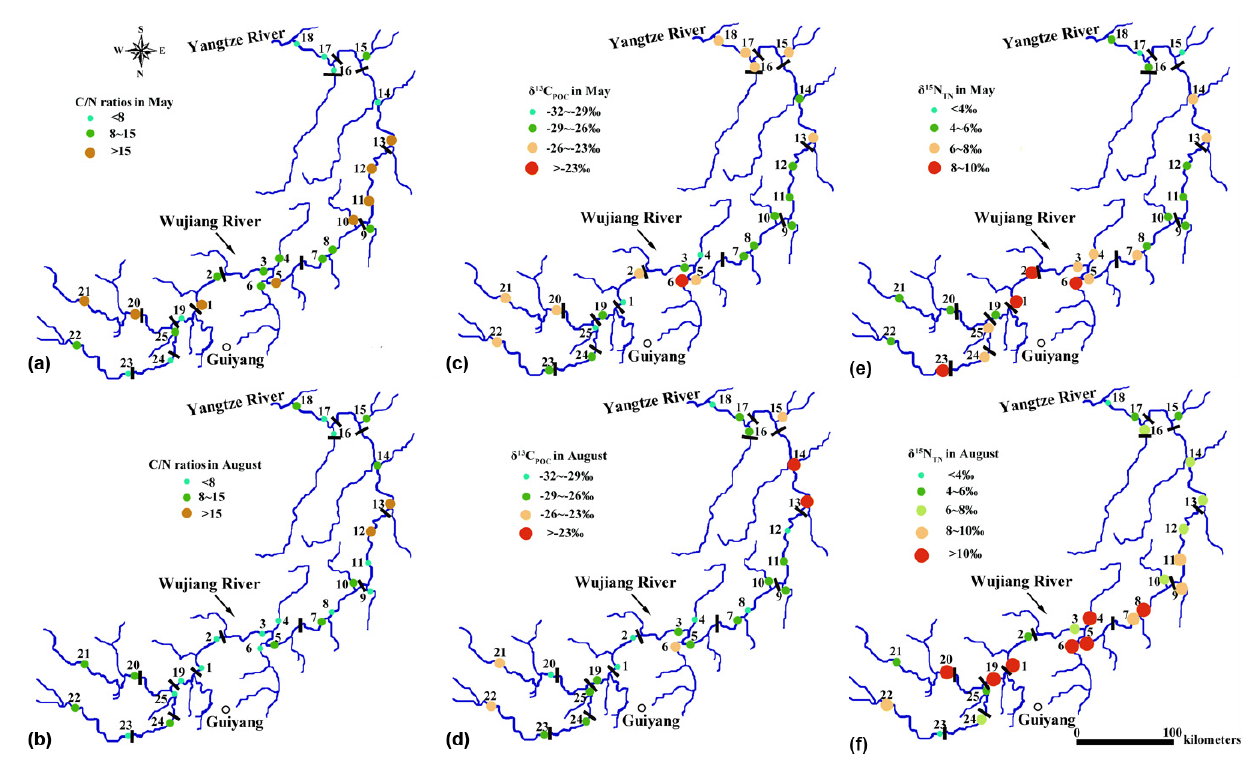
Figure 3. The spatial variations of C / N ratios, δ 13 C POC and δ 15 C TN of suspended particulate matter in the Wujiang River. Table 1. Comparison of TSS concentrations, C / N ratios and isotopic values (mean ± standard deviation) in sites affected by reservoirs with those unaffected by reservoirs in the Wujiang